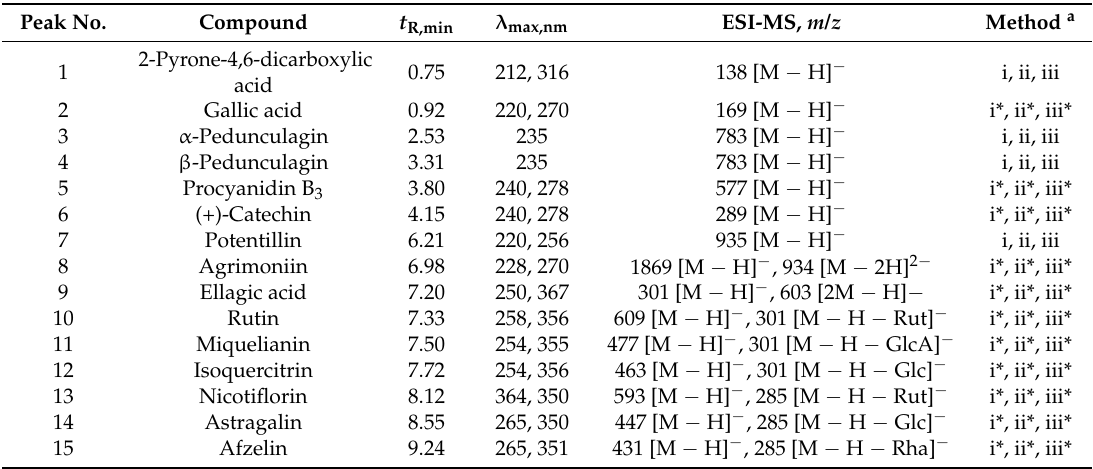
Table 2. MC-RP-HPLC-UV-MS characterization of the components of C. palustre extract. Peak